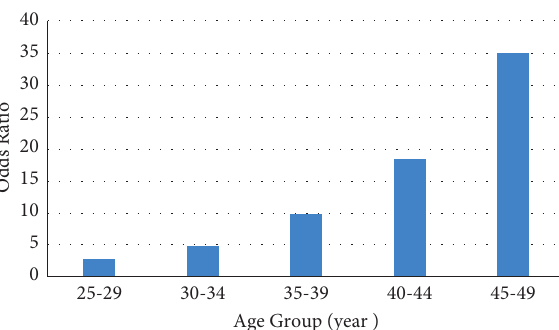
Figure 2: Odds ratio of CRC in different age groups.